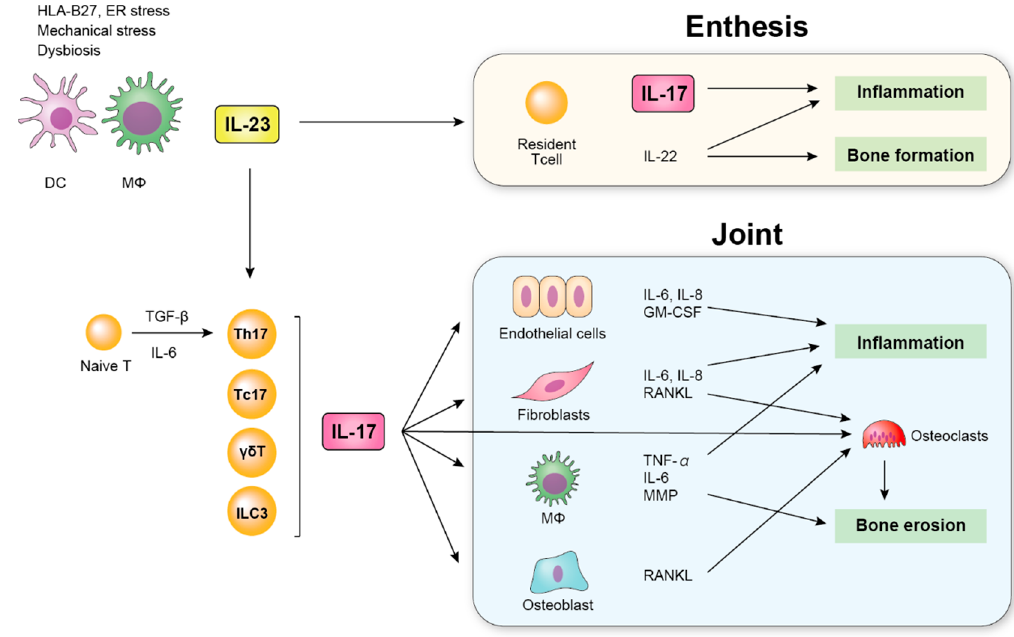
Figure 2. Schematic overview of the role of IL-23 and IL-17 in SpA. Dendric cells (DCs) and macrophages (M Φ s) produce IL-23. IL-23 induces the production of IL-17 by various cells and contributes to inflammation by upregulating the production of inflammatory cytokines such as IL-6 and TNF- α , which induces inflammation in the enthesis and